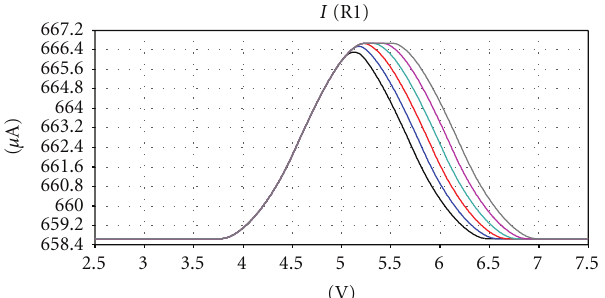
Figure 16: Width and position tunability through right side.